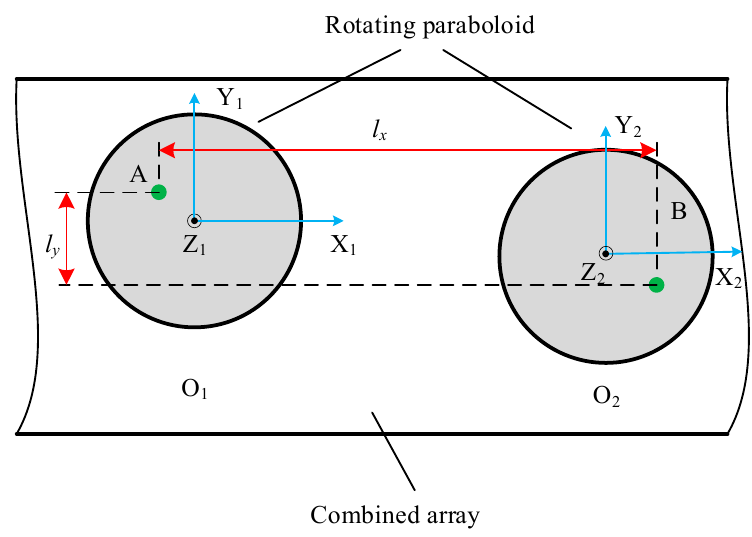
Figure 13. Schematic of large range measurement.